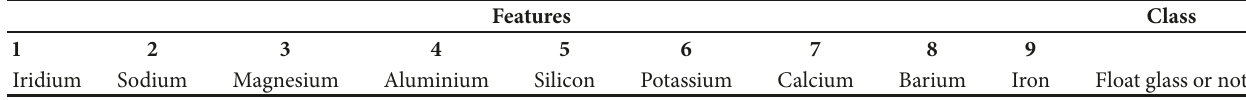
Table 4: The 9 features and classes of dataset “Glass”.